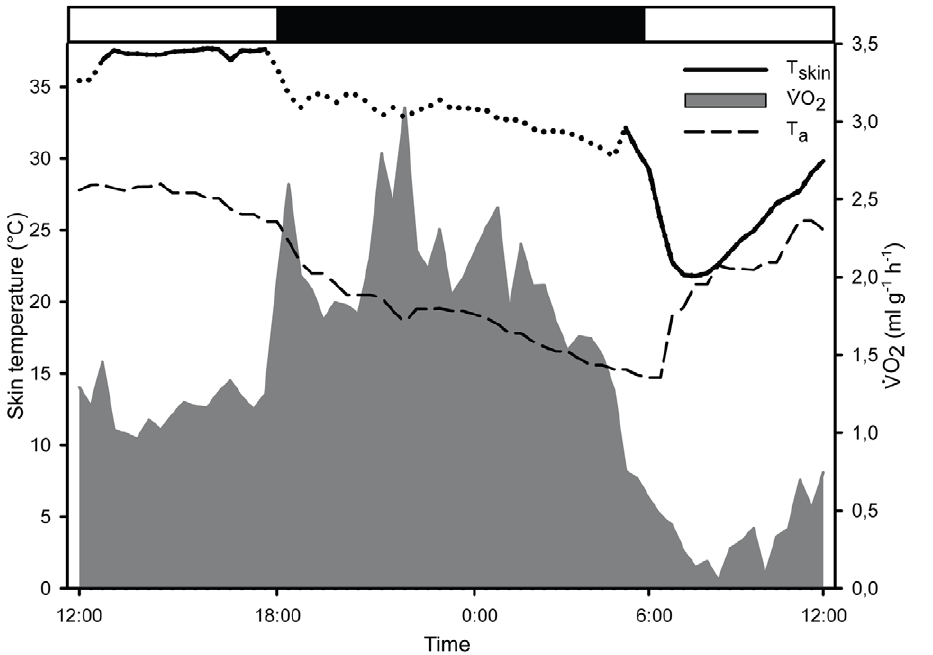
Figure 2. Metabolic rate and skin temperature of a sub adult female G.moholi including a torpor bout. Skin temperature (T skin ) started dropping below 30 u C in the morning at 5:30am; Metabolic rate ( _ VVO 2 ) started decreasing earlier at 4am. The female was torpid for about six hours. Grey area illustrates _ VVO 2 , black line shows T skin , dotted line indicates the period of artificial variations in T skin measurements due to movements of the animal, dashed line shows ambient temperature in the laboratory room (T a ); black bar indicates the dark phase, white bars indicate the daytime.